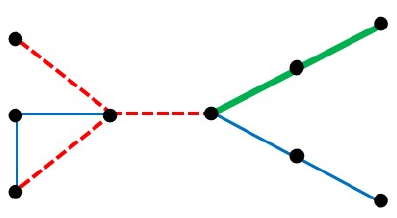
Figure 3. A colorable unicyclic graph distinct from cycle which requires 3 colors for locally irregular edge